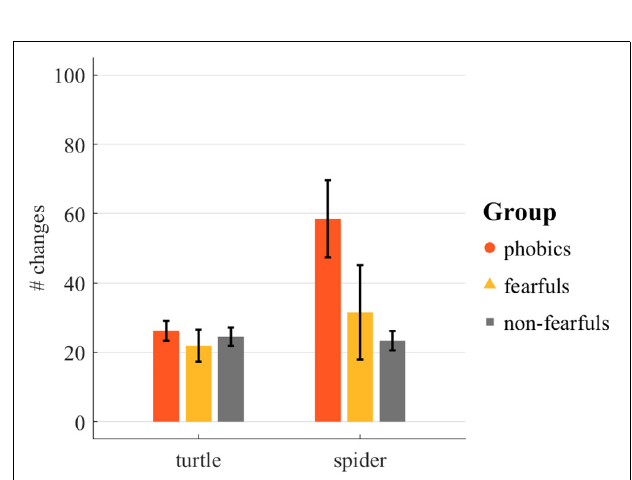
FIGURE 9 | The number of changes in acceleration of the right hand on the way to the stimulus in the Touch the Enemy task. The individual values were truncated to 100. The rmANOVA revealed a significant main effect of group, stimulus, and trial, and a significant group × stimulus interaction. Bars = group mean; lines = standard